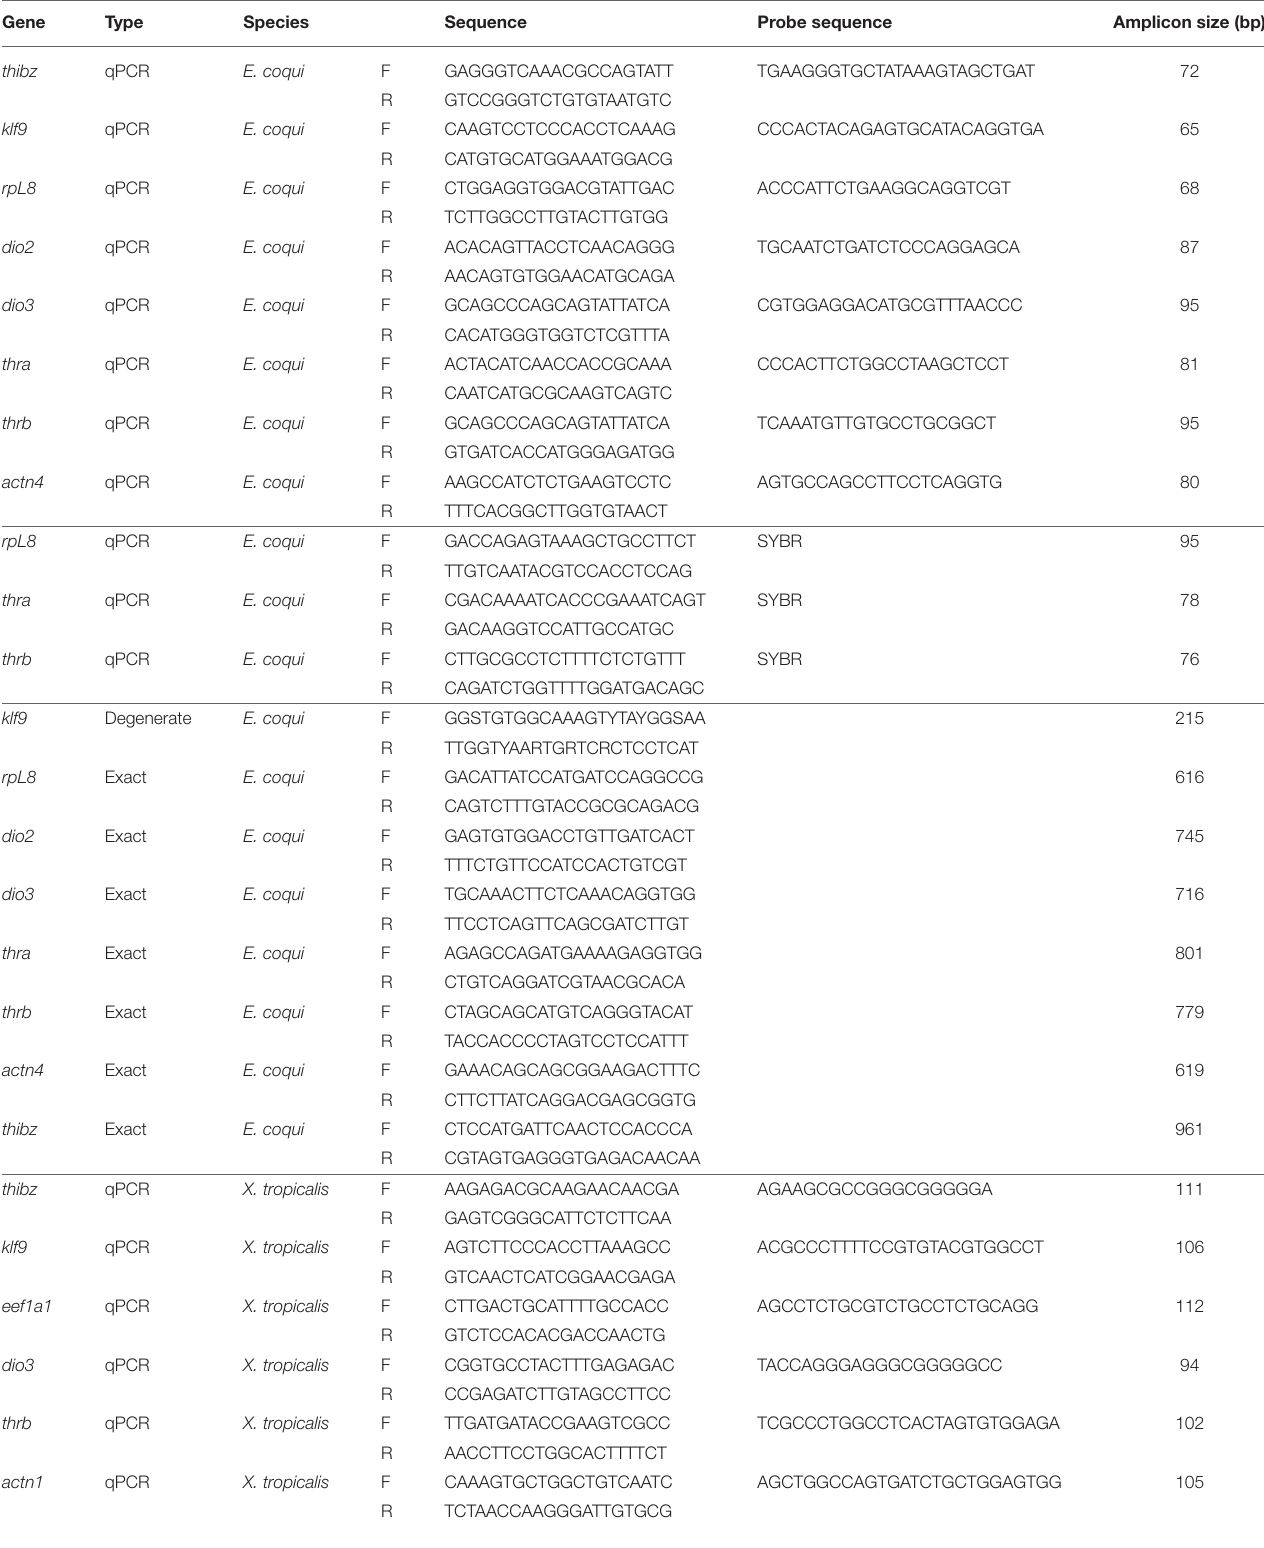
TABLE 1 | Degenerate PCR, exact PCR, and qPCR primers and probes for Eleutherodactylus coqui and Xenopus tropicalis